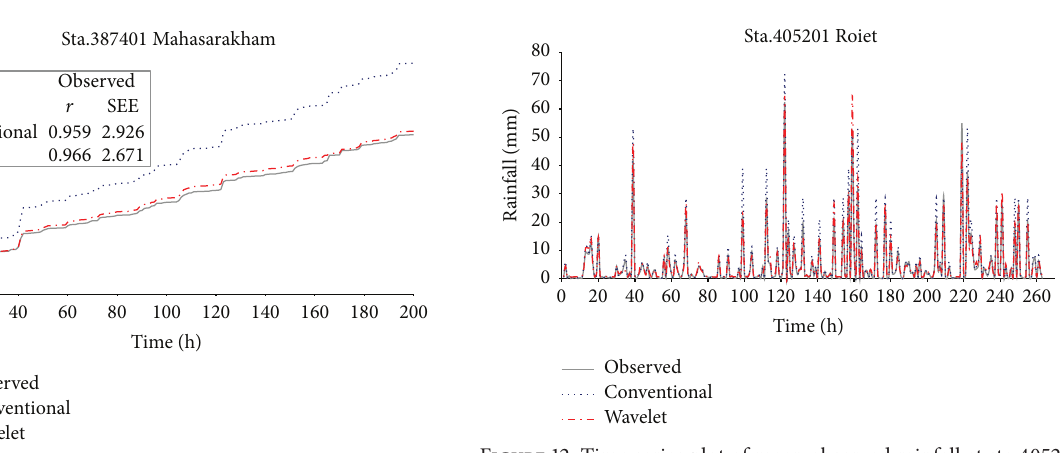
Figure 9: Cumulative observed rainfall data at sta.387401 Mahasarakham during 1 June–31 October 2011 for verification compared with conventional and wavelet filters technique.